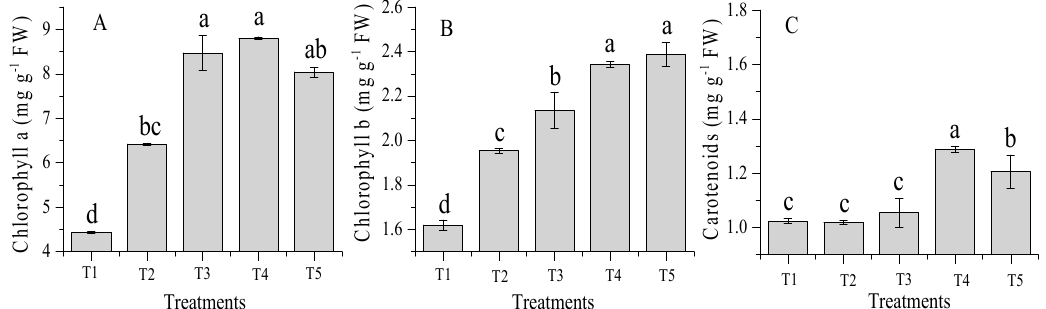
Figure 1. Effect of co-application of TW and chemical fertilizers on chlorophyll a ( A ) and b ( B ) and carotenoid (mg · g − 1 ) ( C ) content in wheat leaves under without amendment (T1), chemical fertilizers (T2), TW 2.5% + F (T3), TW 5% + F (T4) and TW 10% + F (T5). The data showed the mean of three replications, and error bars are standard deviations. Different letters indicate there were significant differences ( p < 0.05) in the LSD means comparisons between the treatments mean. Table 1. Influence of chemical fertilizers alone and combined with milk tea waste (TW) on plant height, shoot, and root dry weight and leaf ar ea index parameters after 8 weeks (mean ± standard error; n = 3).